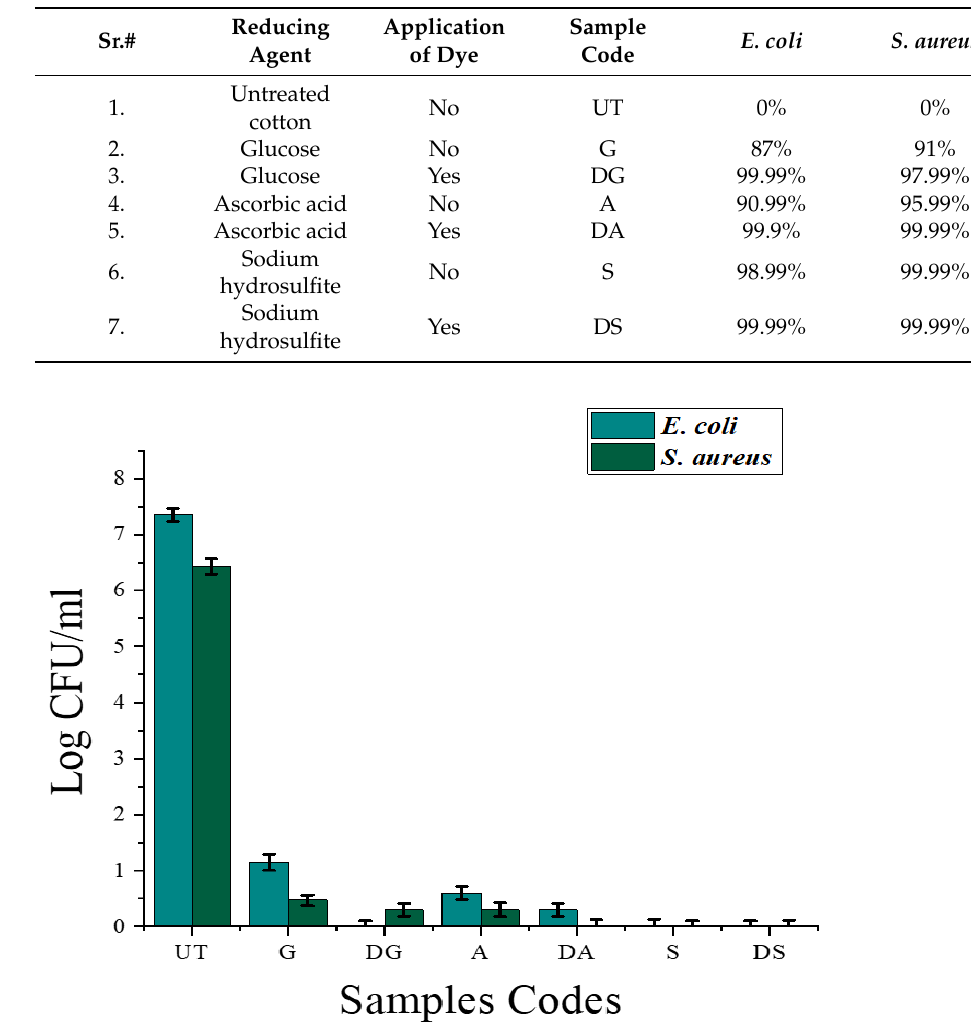
Figure 11. The reduction in CFUs of surviving bacterial colonies for all developed samples against S. aureus and E. coli.